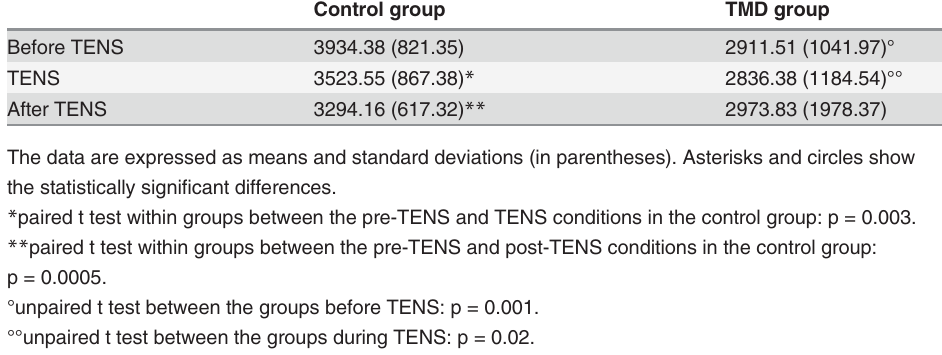
Table 2. Comparison between Pupil Size in the Control and TMD Groups in the Yellow-Green Light Condition. Yellow-Green pupil size Before TENS TENS After TENS 3294.16 (617.32) ** 2973.83 (1978.37)